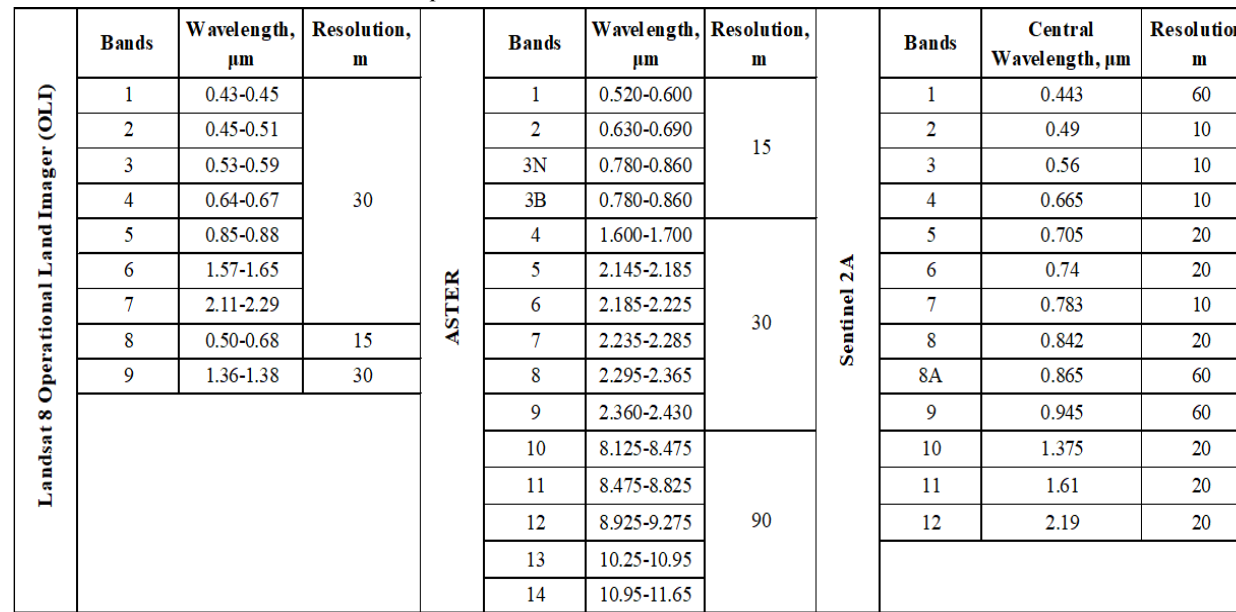
Table 1. The characteristics of spectral bands of Landsat 8 OLI and ASTER , and Sentinel